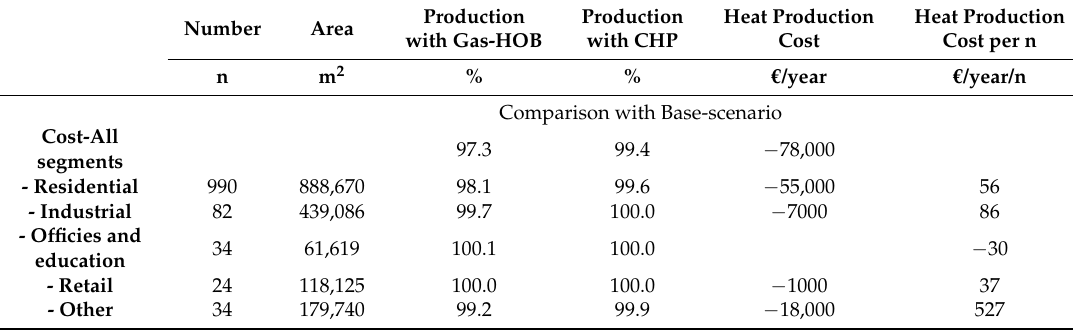
Table 3. The effect of the Cost scenario DSM implementation on separate customer segments in the medium-sized DH system. The first row in the table (Cost—All segments) represents the situation when all the customers are implementing DSM within the Cost scenario. The following rows represent the situation when only one customer segment implements DSM within the Cost scenario, and others follow the Base scenario. The results are compared to the Base scenario.